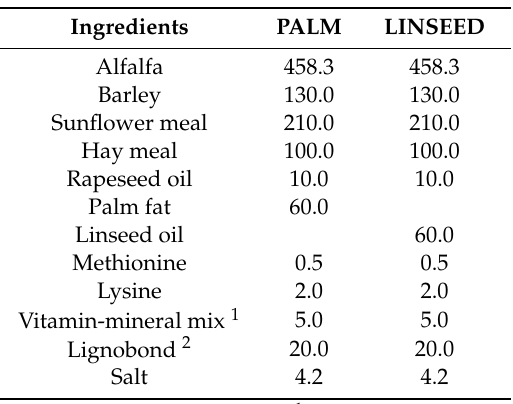
Table 1. Ingredients of the diets (g / kg). Ingredients